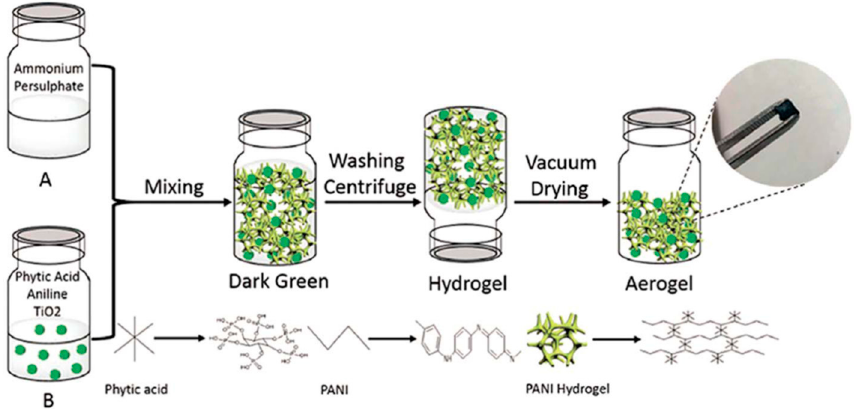
Figure 23. Schematic illustration demonstrating the synthesis process of the 3D PANI/TiO 2 composite hydrogel. Adapted with permission from Reference [122]. Copyright (2015) Wiley.